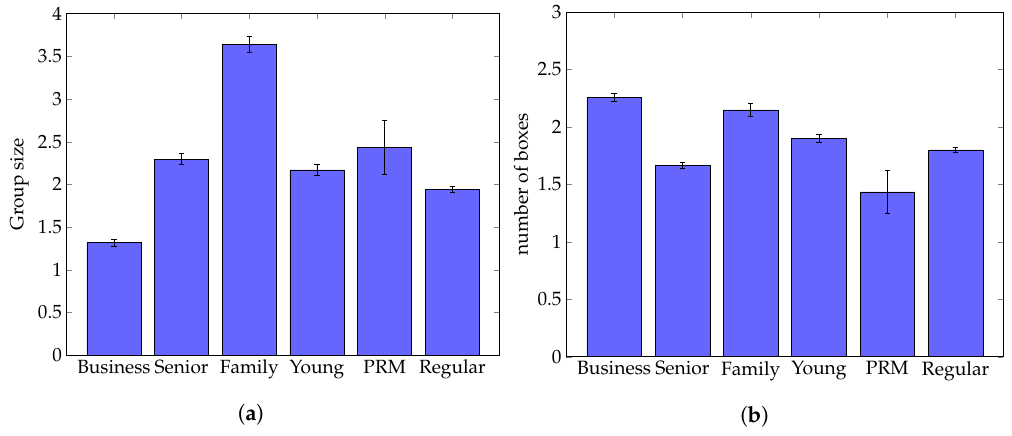
Figure 6. Statistics related to group sizes and number of boxes for the six different passenger types in the entire dataset. ( a ) The mean group size per passenger type. ( b ) The mean number of boxes per passenger type.